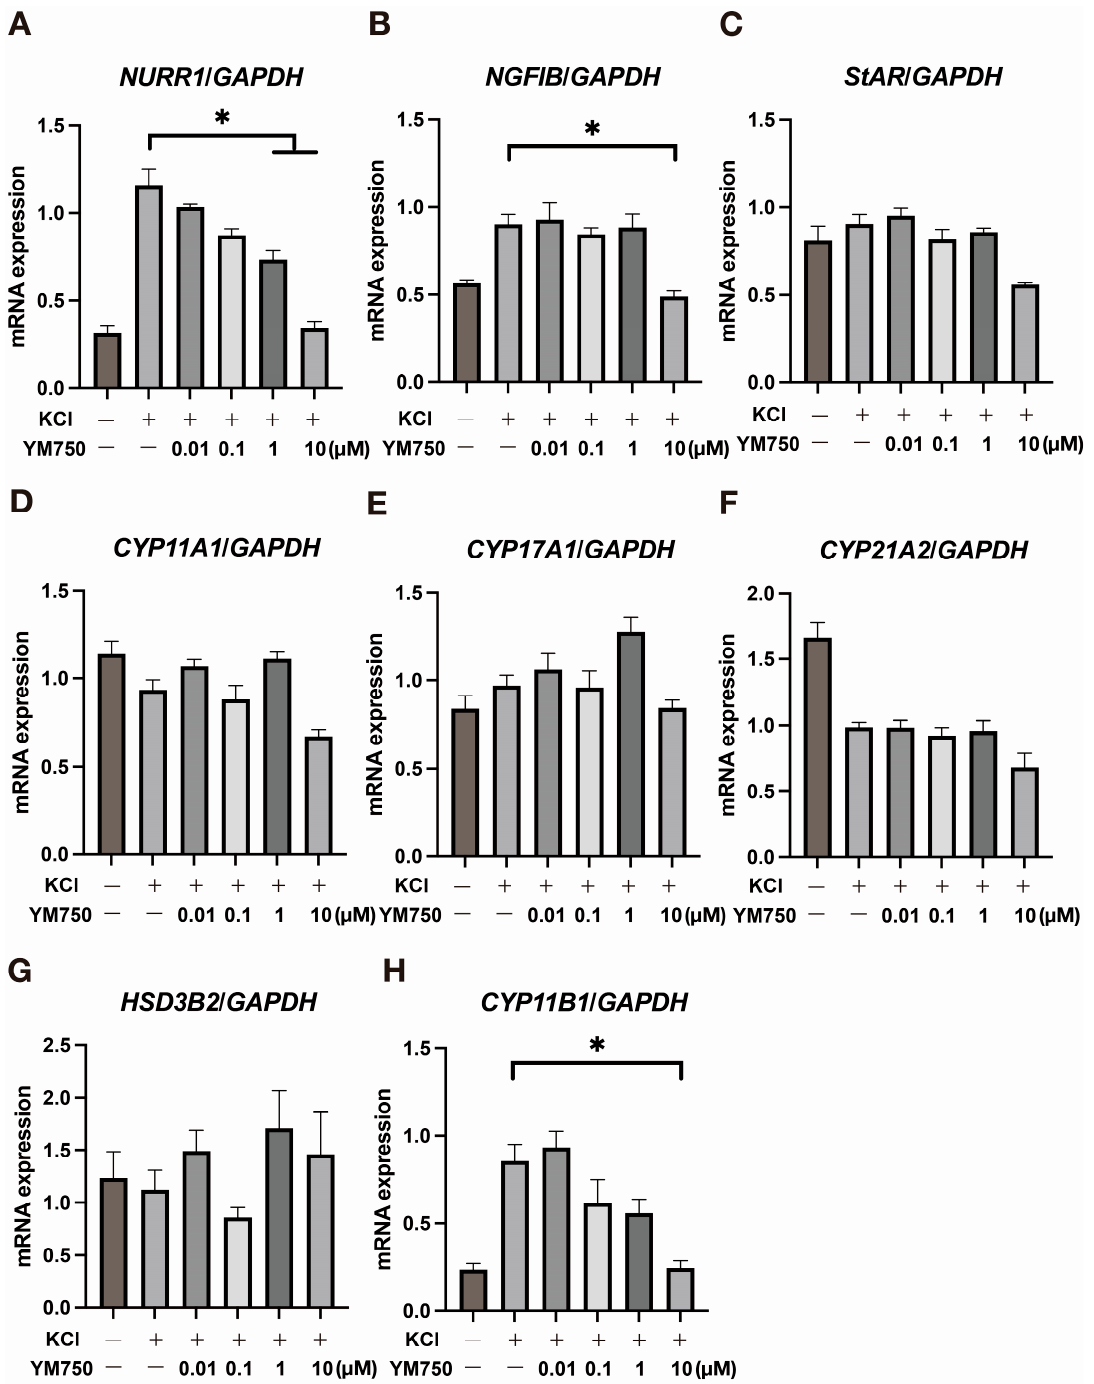
Figure 2. Effect of YM750 on the expression of various steroidogenic enzymes and CYP11B2 related genes. Effect of YM750 on ( A ) NURR1 , ( B ) NGFIB , ( C ) StAR , ( D ) CYP11A1 , ( E ) CYP17A1 , ( F ) CYP21A2 , ( G ) HSD3B2 and ( H ) CYP11B1 expression induced by KCl stimulation. * p < 0.05, n = 3.